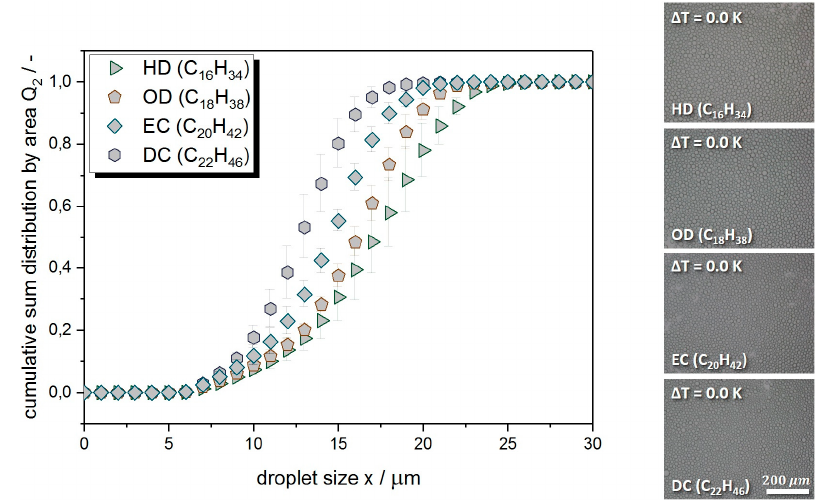
Figure A1. Cumulative sum distribution by area Q 2 of 1 wt % alkane in water emulsions stabilized with 1 wt % Tween20 ® and measured at ϑ m , alkane with PLM/IP. Triangles: DSD of hexadecane dispersions. Pentagons: DSD of octadecane dispersions. Diamonds: DSD of eicosane dispersions. Hexagons: DSD of docosane dispersions. Length of the scale bar is 200 µm.